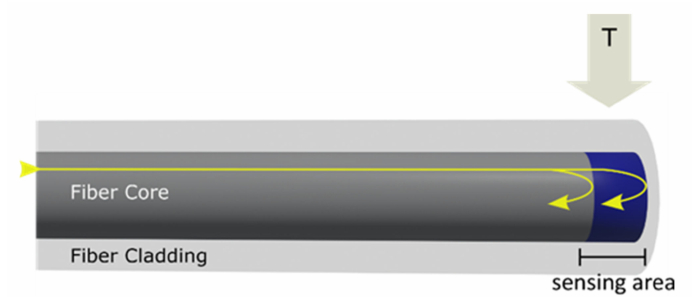
Figure 5. Extrinsic POF FPI for temperature